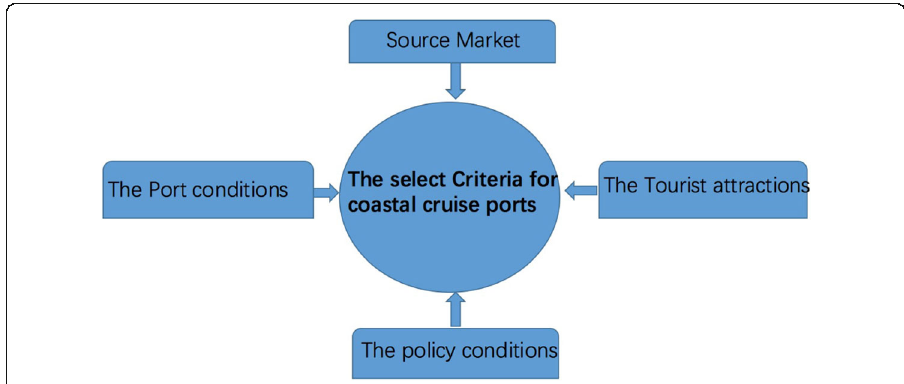
Fig. 3 The select criteria for coastal cruise ports. Source: authors